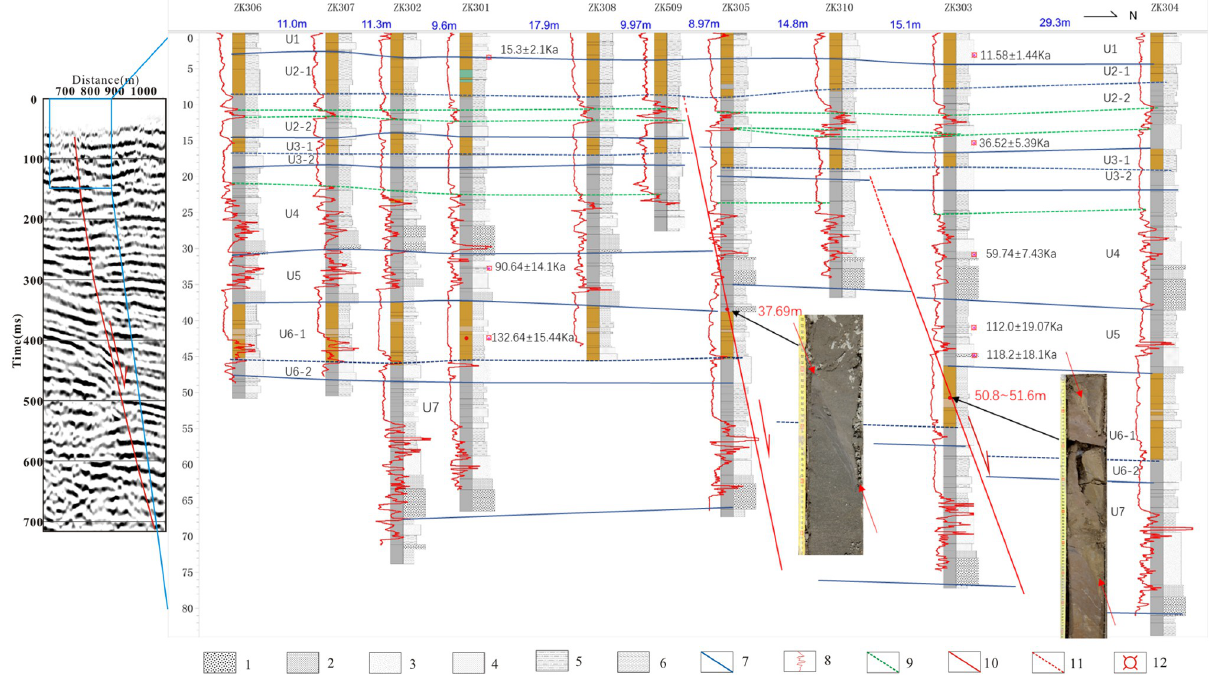
Fig 6. Combined profile of borehole histogram superimposed with magnetic susceptibility logging curve at Xiwugezhuang on L3 Survey line. 1. coarse sand; 2.median sand; 3.fine sand; 4.silt; 5 clay silt; 6.clay; 7 stratigraphic unit boundary line; 8. Magnetic susceptibility curve; 9. Magnetic susceptibility characteristic point line; 10 fault; 11.inferred fault; 12. OSL sample.